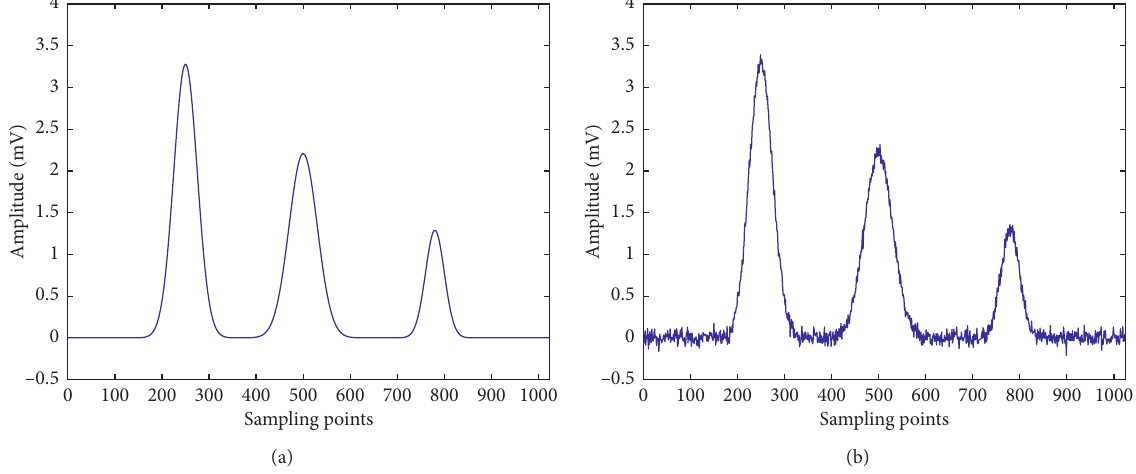
Figure 5: Simulation ME-C 4 D signal and its noisy signal. (a) Simulation ideal signal. (b) Simulation noisy